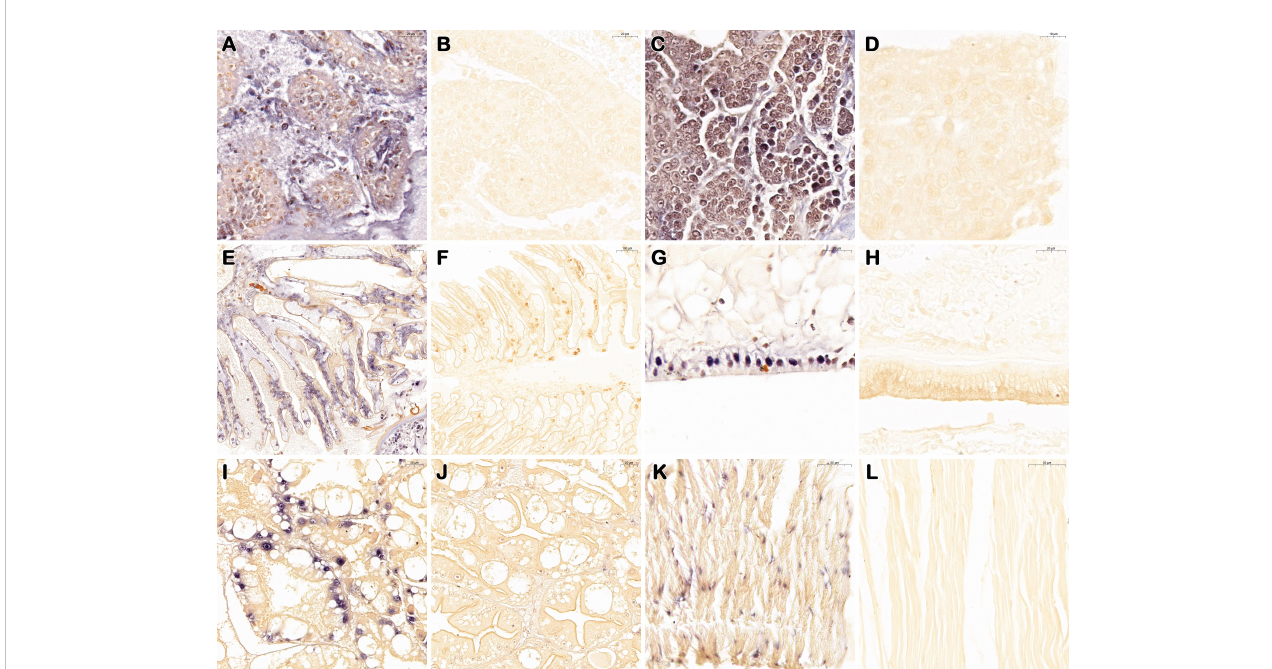
FIGURE 4 In situ DIG-labeling loop-mediated isothermal ampli fi cation targeting DIV1 on histological sections of P. japonicus . Lymphoid organ, hemopoietic tissue, gills, epithelial tissue, hepatopancreas, and muscle of DIV1 infected individuals (from PO and IM groups) (A, C, E, G, I, K) ; Lymphoid organ, hemopoietic tissue, gills, epithelial tissue, hepatopancreas, and muscle of healthy individuals (from CPO and CIM groups) (B, D, F, H, J, L) . Bar, 20 m m (A – C, G – J) ; 10 m m (D) ; 50 m m (E, K, L) ; 100 m m (F)